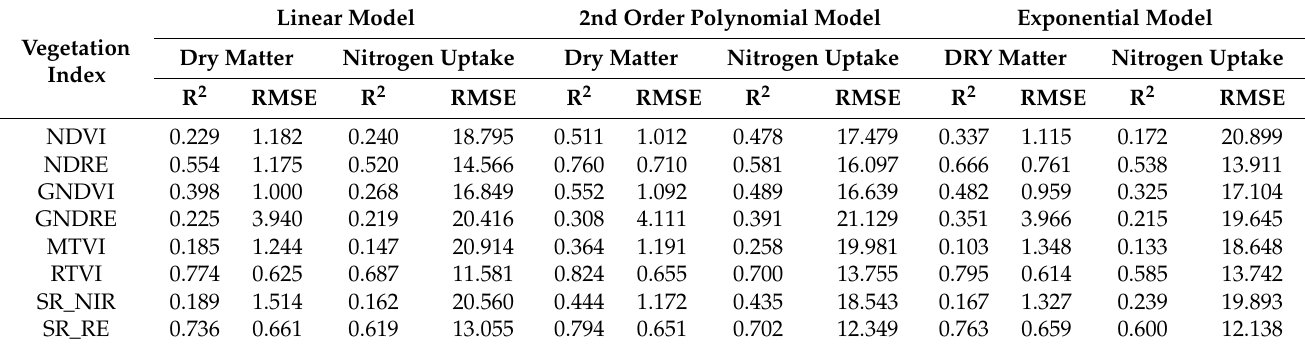
Table 4. Average of the R 2 and RMSE coefficients, at the level of each variety and for each index.